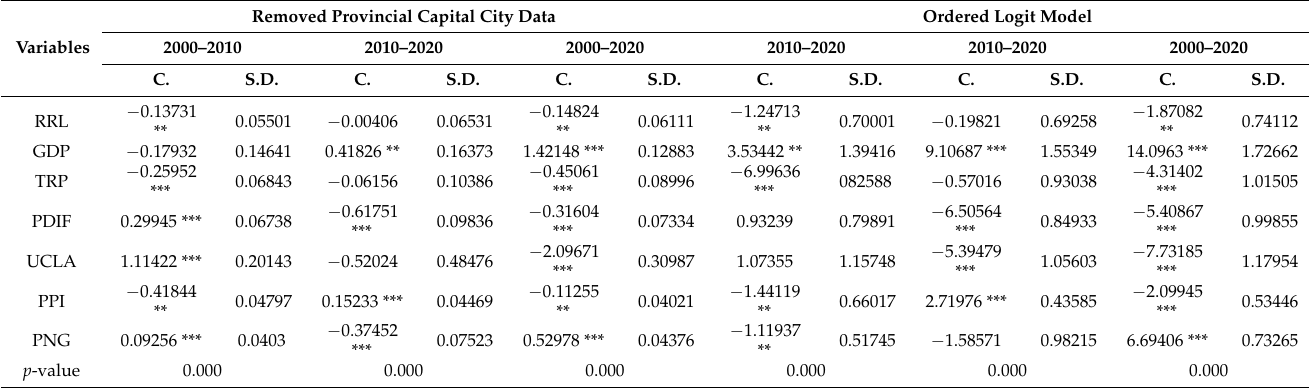
Table 6. Robustness